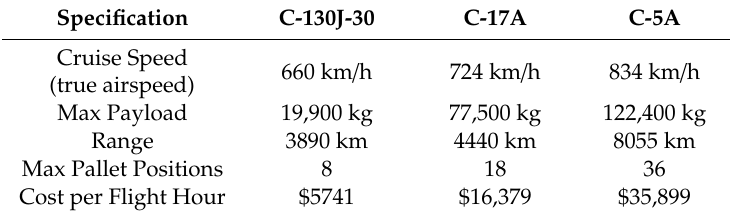
Table 2. US Air Force cargo aircraft specifications